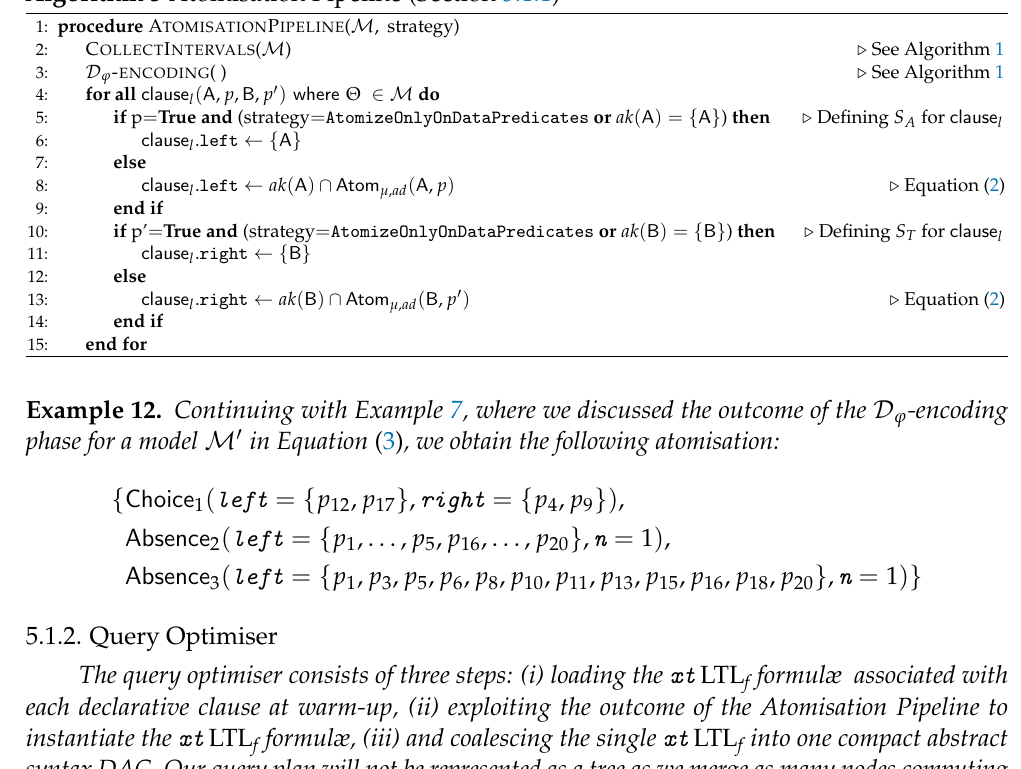
Algorithm 3 Atomisation Pipeline (Section